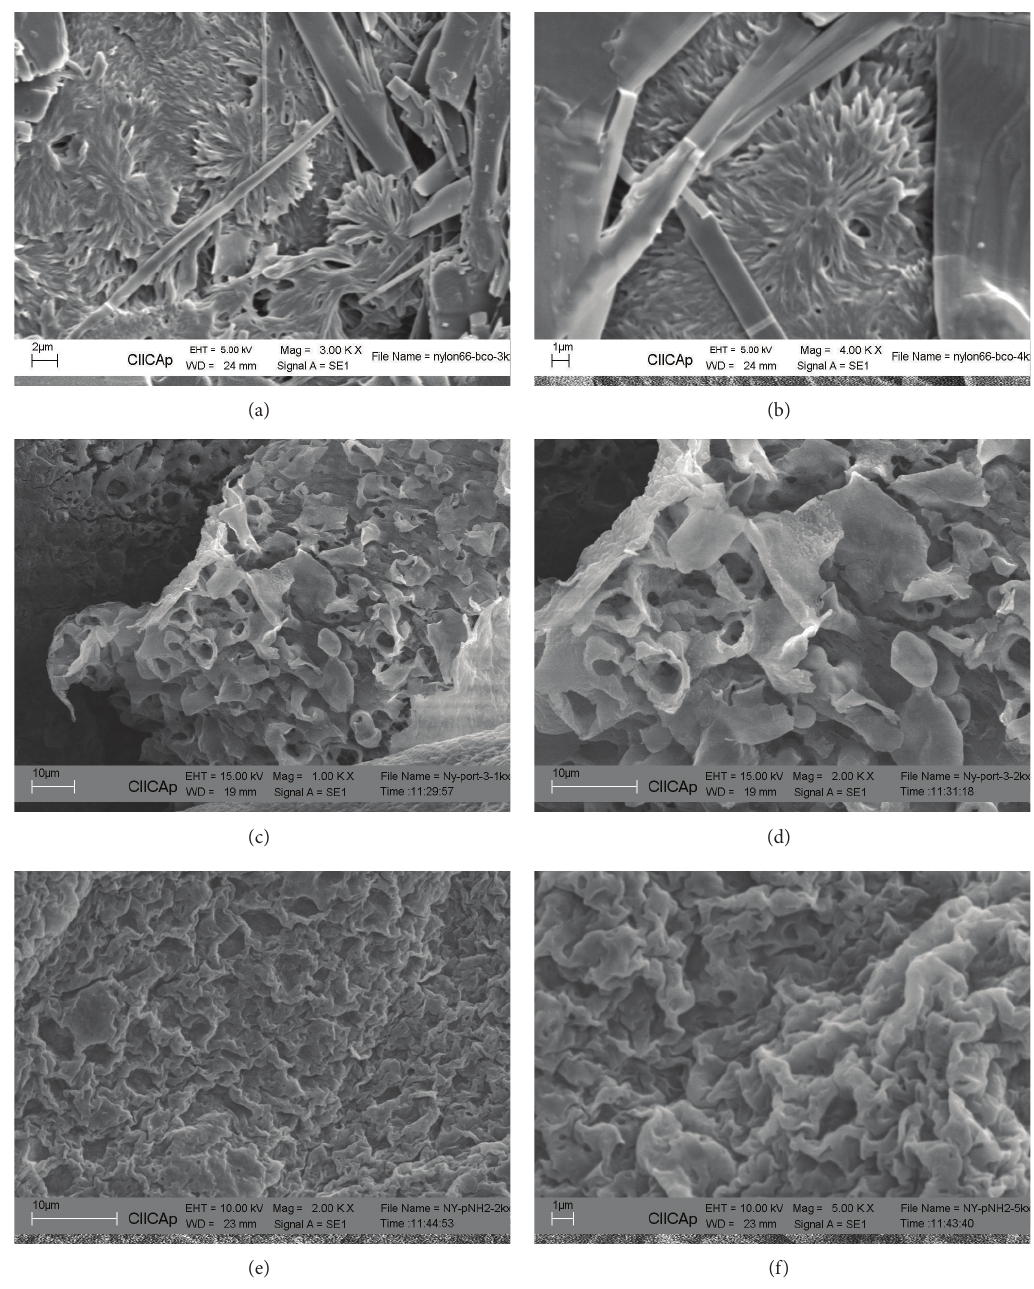
Figure 11: SEM images of Nylon-66 ((a) and (b)), Ny 66- o -NH 2 ((c) and (d)) and, Ny 66- p -NH 2 ((e) and (f))